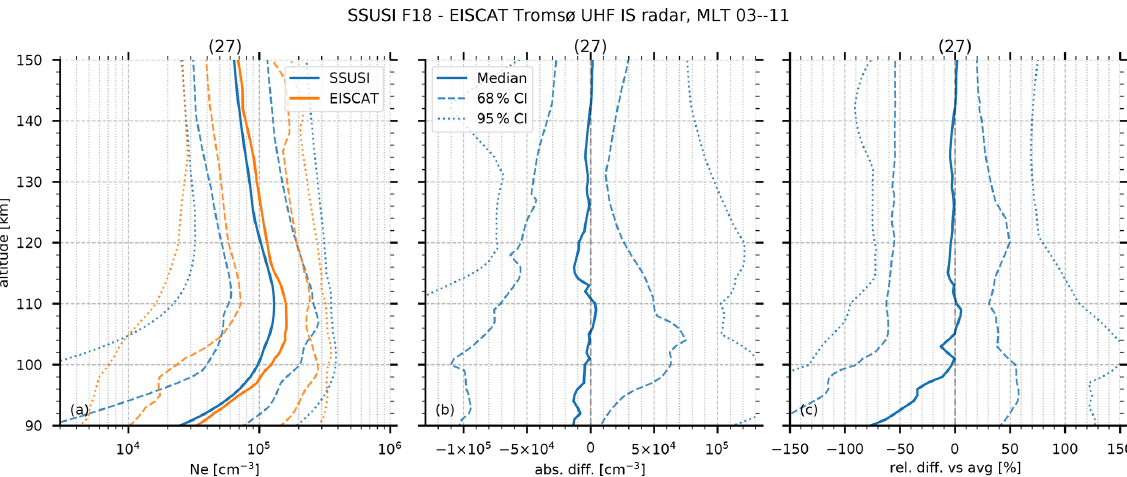
Figure 3. Profile comparison as in Fig. 2 for SSUSI on DMSP/F18 and the EISCAT Tromsø UHF radar for early MLT (03:00–11:00MLT).